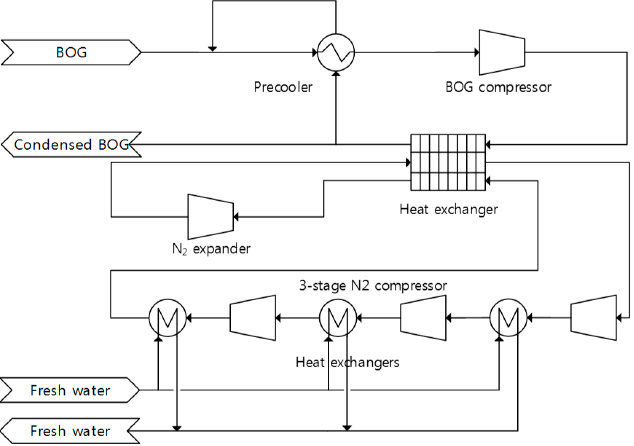
Figure 3. Process flow diagram of Hamworthy Mark-1 re-liquefaction process.